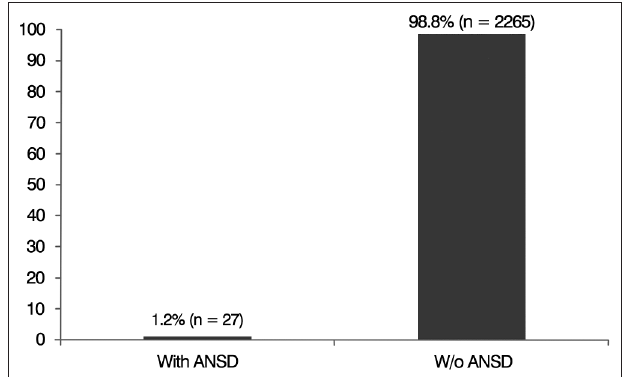
Graph 1. Percent distribution of subjects with auditory neuropathy spectrum disorder (ANSD).